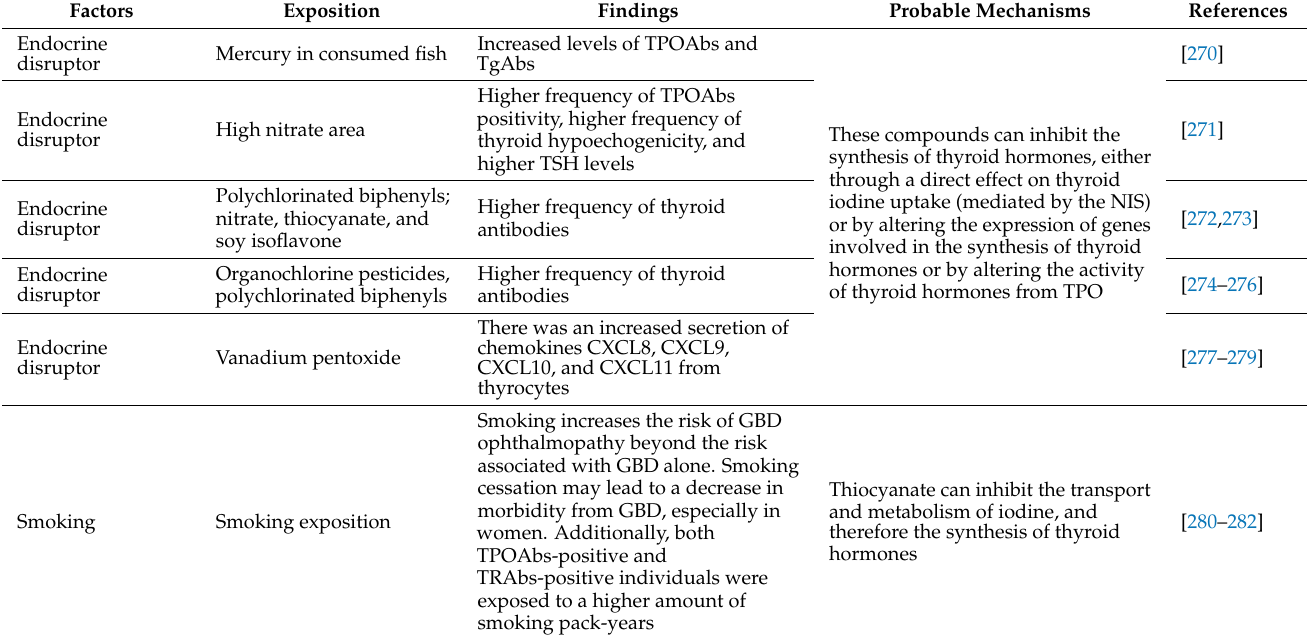
Table 8. Non-genetic and nonnutritional factors most frequently associated with